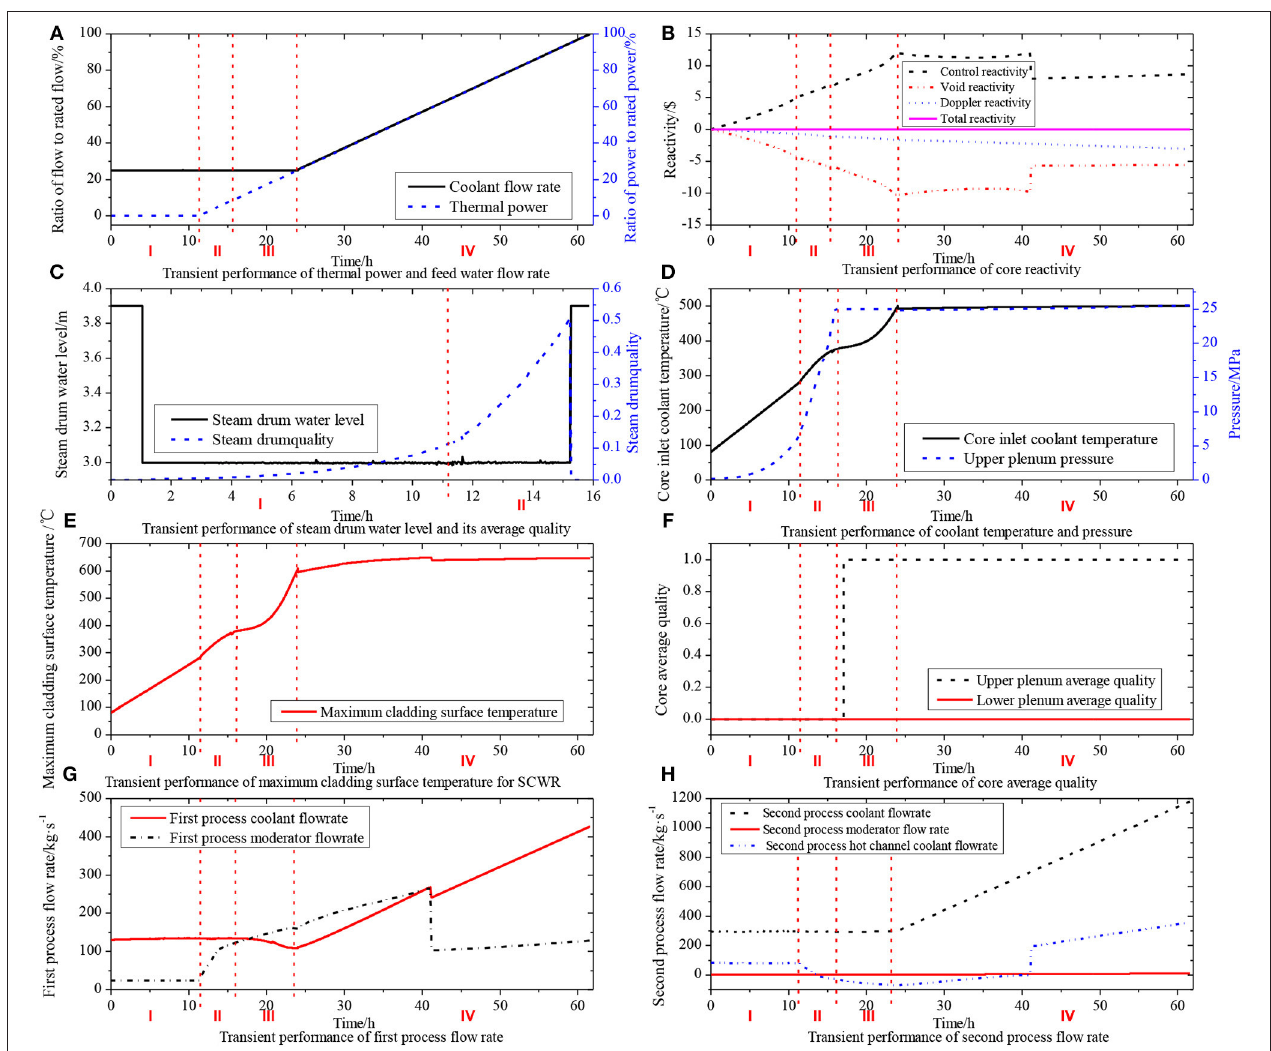
FIGURE 9 | Transient performance of the startup procedure. (A) Transient performance of thermal power and feed water flow rate. (B) Transient performance of the core reactivity. (C) Transient performance of the steam drum water level and its average quality. (D) Transient performance of the coolant temperature and pressure. (E) Transient performance of the maximum cladding surface temperature for SCWR. (F) Transient performance of core average quality. (G) Transient performance of the first process flow rate. (H) Transient performance of the second process flow